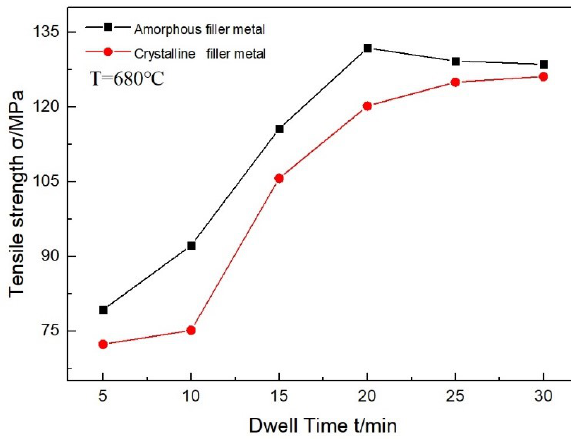
Figure 8: Tensile strength of joints formed with amorphous and crystalline filler metal vs. dwell time (brazing temperature=680 ∘